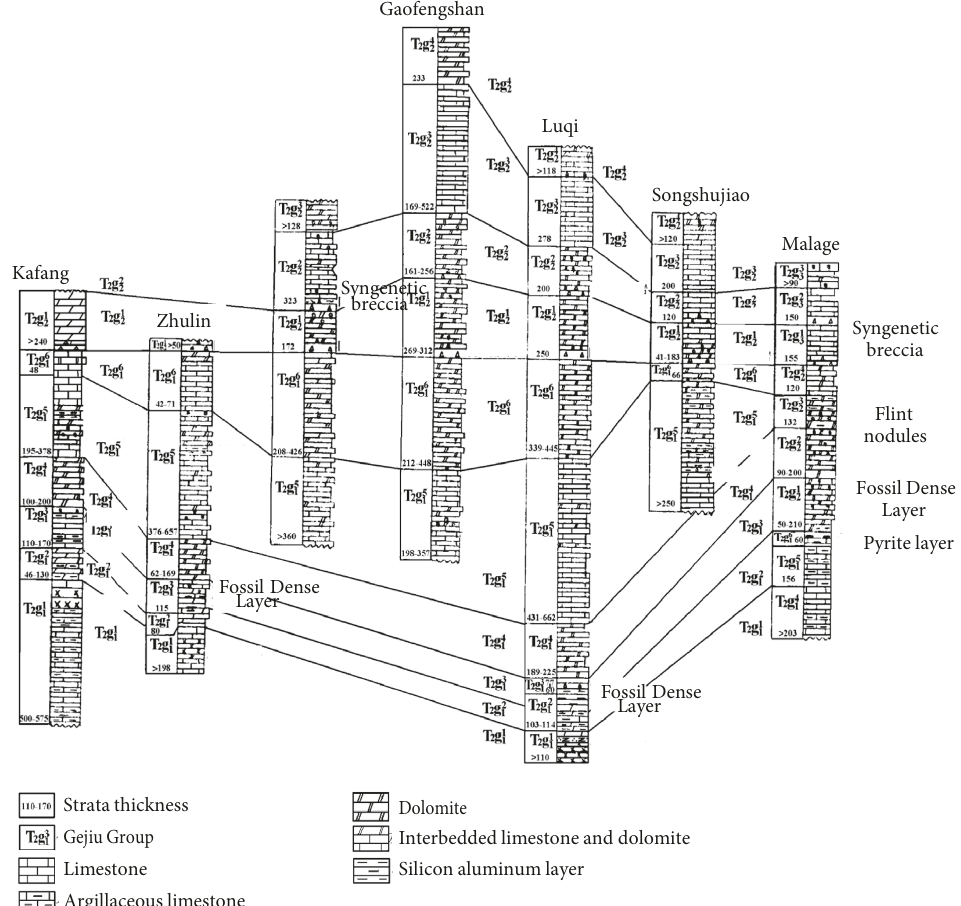
Figure 3: Correlation scheme for the geological sections of the Gejiu group.